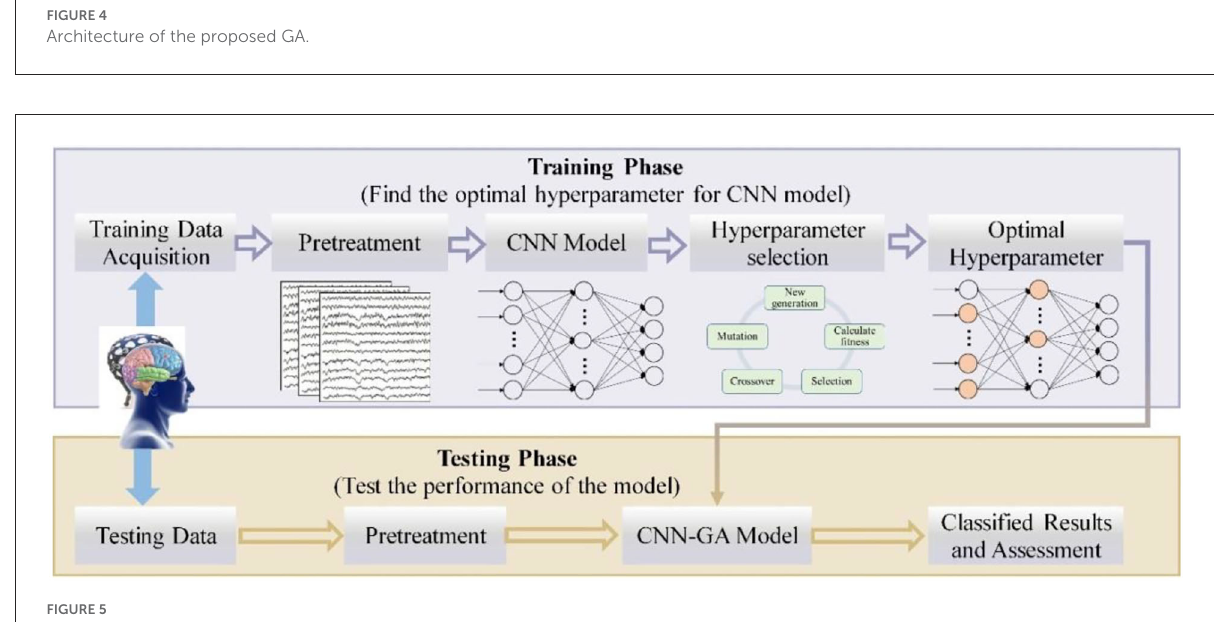
one pooling layer, and three fully connected layers. Two batch normalization (BN) and one dropout were also used in the proposed CNN–GA model. Because the third fully connected layer is used to output the discrimination result from the four expression-based EEG signals, the number of neurons in this layer was four, and its activation function was selected as Softmax. The initial values for the CNN model parameters were a batch size of 16, a learning rate of 0.001, 100 iterations, and a cross-entropy loss function. The numbers of convolution kernels (in the three convolutional layers) and neurons (in the two fully connected layers) were set via GA